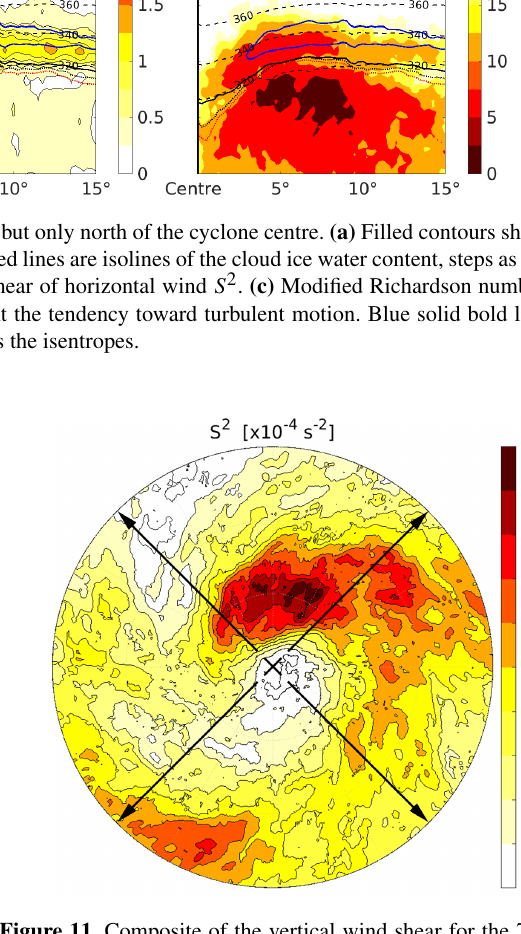
Figure 11. Composite of the vertical wind shear for the 76 strong cyclones with p msl , min ≤ 990hPa at the point in time of maxi- mum intensity, averaged over the individual quasi-horizontal fields of maximum vertical wind shear S 2 max found within 3km above the lapse rate tropopause for each cyclone. The black arrows indicate the orientation of the vertical cross sections in Fig.